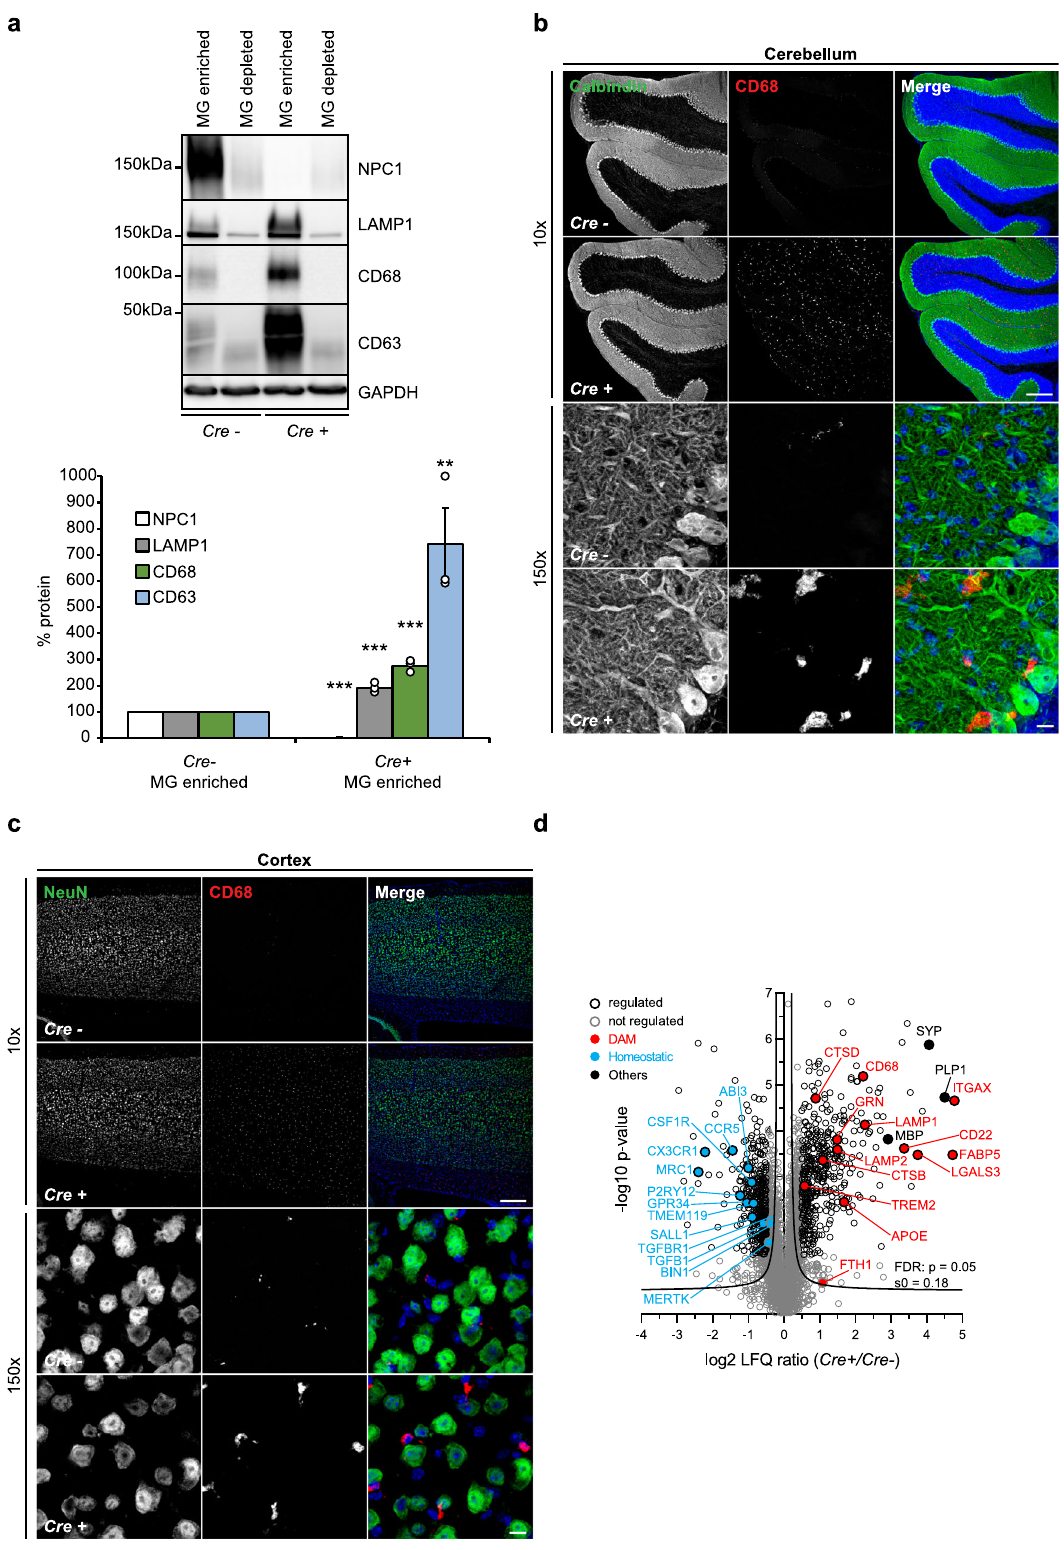
were ef fi ciently degraded, myelin accumulated within Npc1 − / − microglia (Supplementary Fig. 4b), suggesting possible impair- ments in myelin turnover. Next, we investigated the turnover of exogenously added myelin in cultured Npc1 − / − microglia isolated from pre- symptomatic mice. Cultured microglia have been pulsed for 6